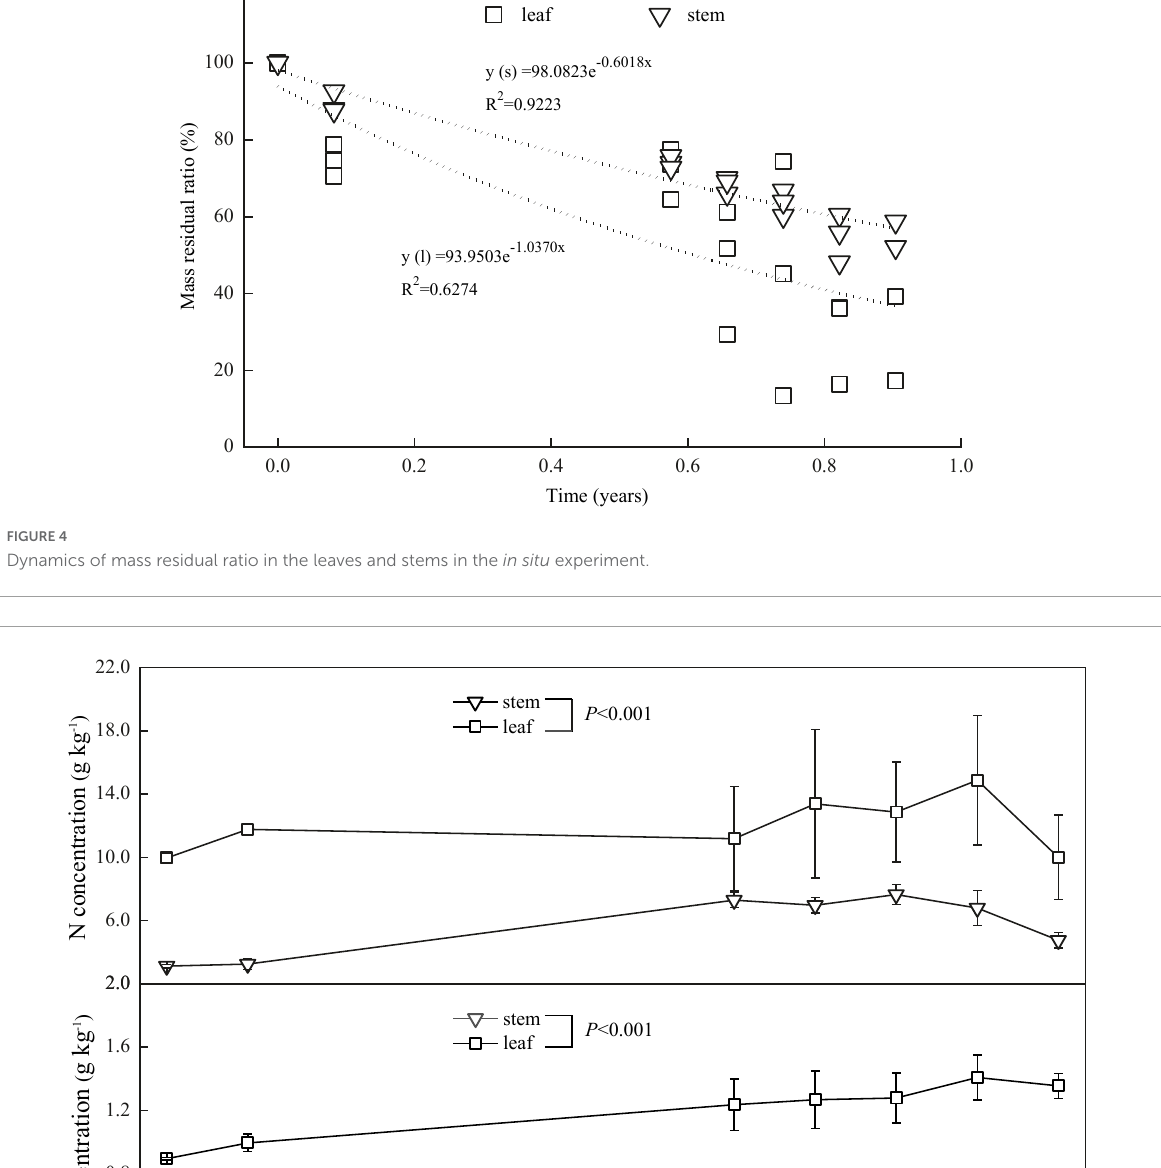
FIGURE5 Concentrations (means ± SD) of nitrogen (N) and phosphorus (P) in the leaves and stems in the in situ experiment.